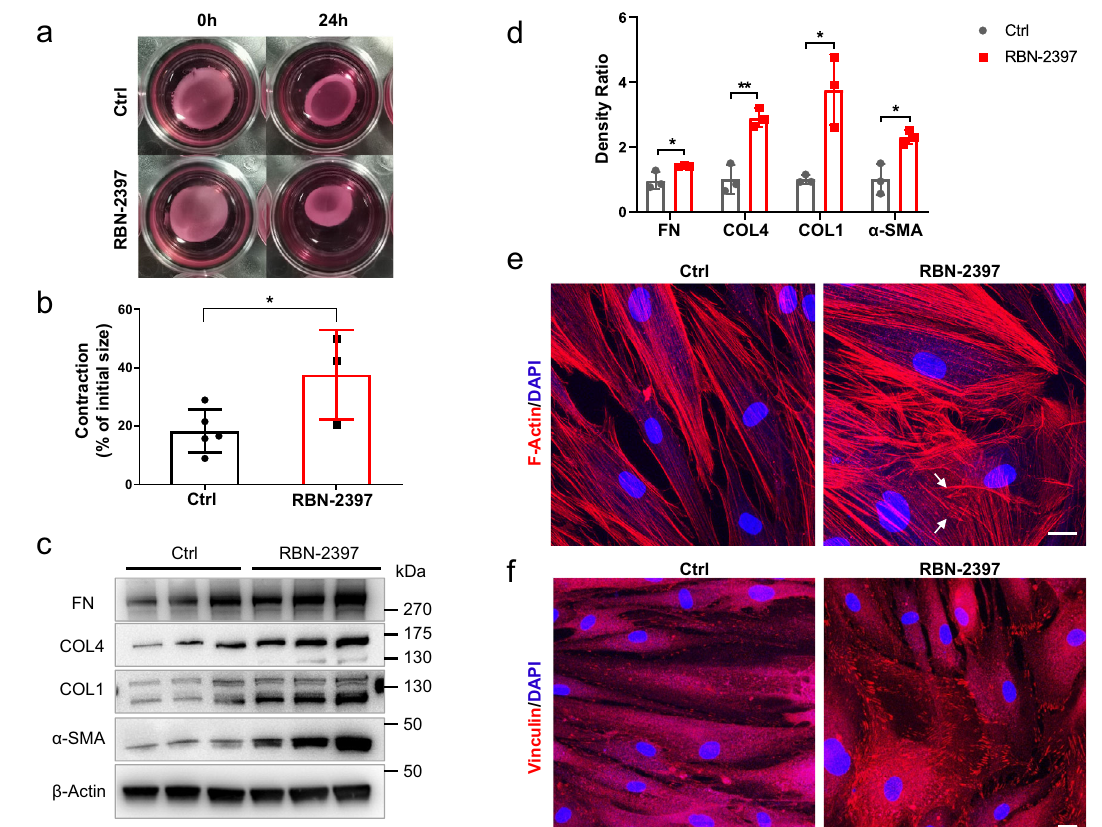
Fig. 5 The TIPARP inhibitor RBN-2397 enhanced HTM cell contraction, ECM deposition, CLAN formation and focal adhesion. a , b HTM cell contractility was measured after 24 h with or without RBN-2397 (1 μ M) exposure. Contraction data are presented as the percent of the initial size (means ± standard deviations). RBN-2397 exposure enhanced HTM cell contraction compared to that of the control cells. ( n = 3 in the RBN-2397 group and n = 5 in the control group, t test). c , d Western blot and quantitative analyses showed that the expression of fi bronectin, collagen type IV, collagen type I and α -SMA increased in RBN-2397-treated HTM cells compared with the control cells ( n = 3, t test). e After 48 h of RBN-2397 treatment, HTM cells increased the formation of CLAN (white arrows), as shown by phalloidin staining, compared to that of the control cells. f The RBN-2397-treated HTM cells exhibited an increase in the focal adhesion marker vinculin by immuno fl uorescence compared to the control cells. Data are presented as the means ± standard deviations. * P < 0.05, ** P < 0.01. Scale bar = 20 μ m. CLAN cross-linked actin network, COL1 collagen type I, COL4 collagen type IV, FN fi